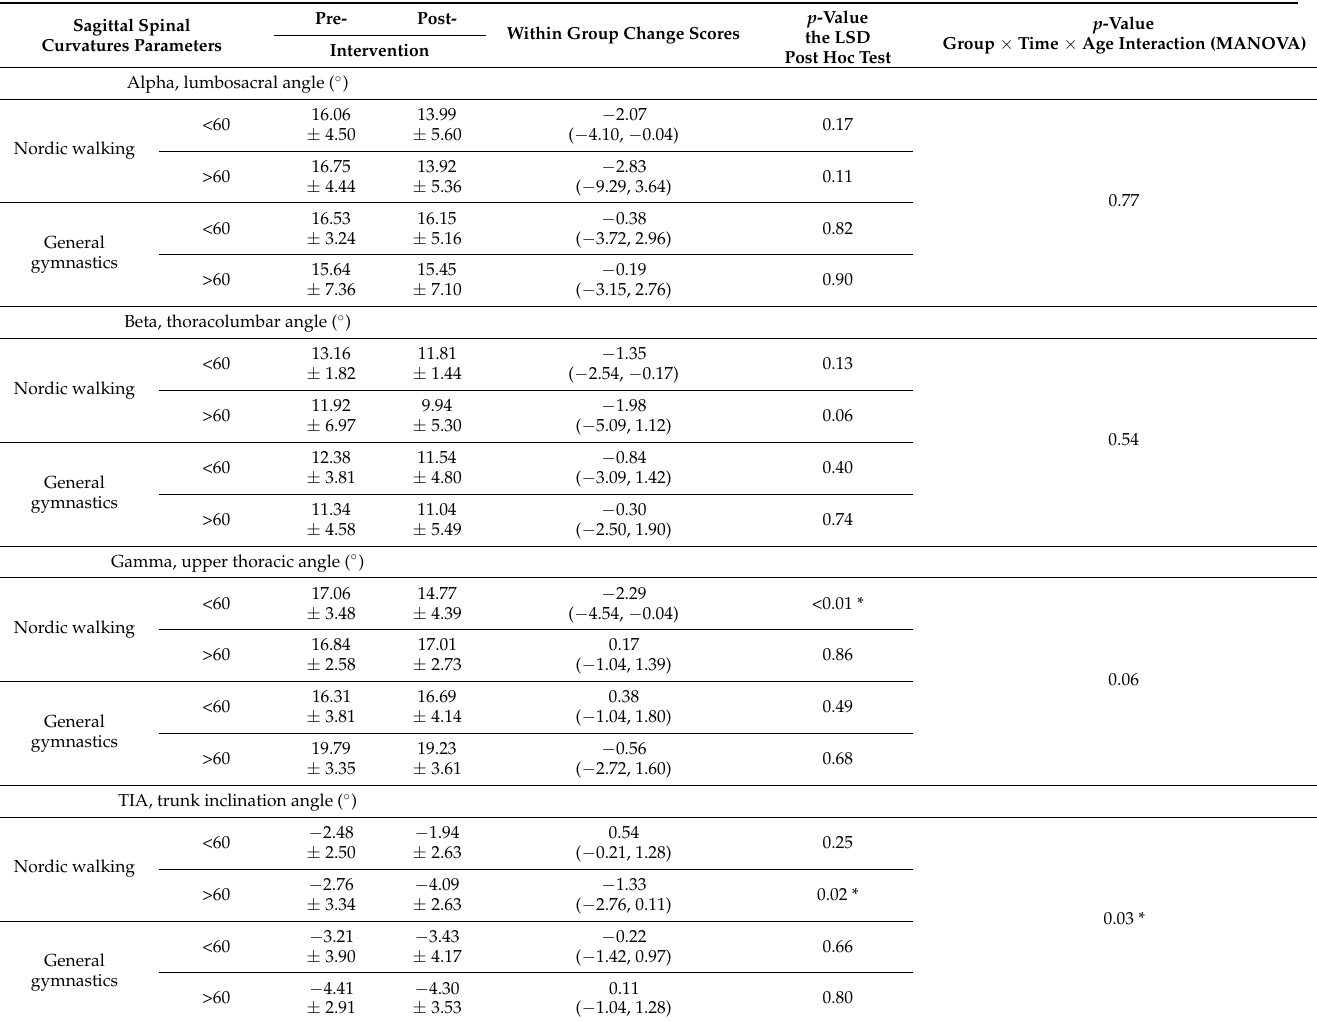
Table 4. Pre- and post-training intervention changes in sagittal spinal curvatures